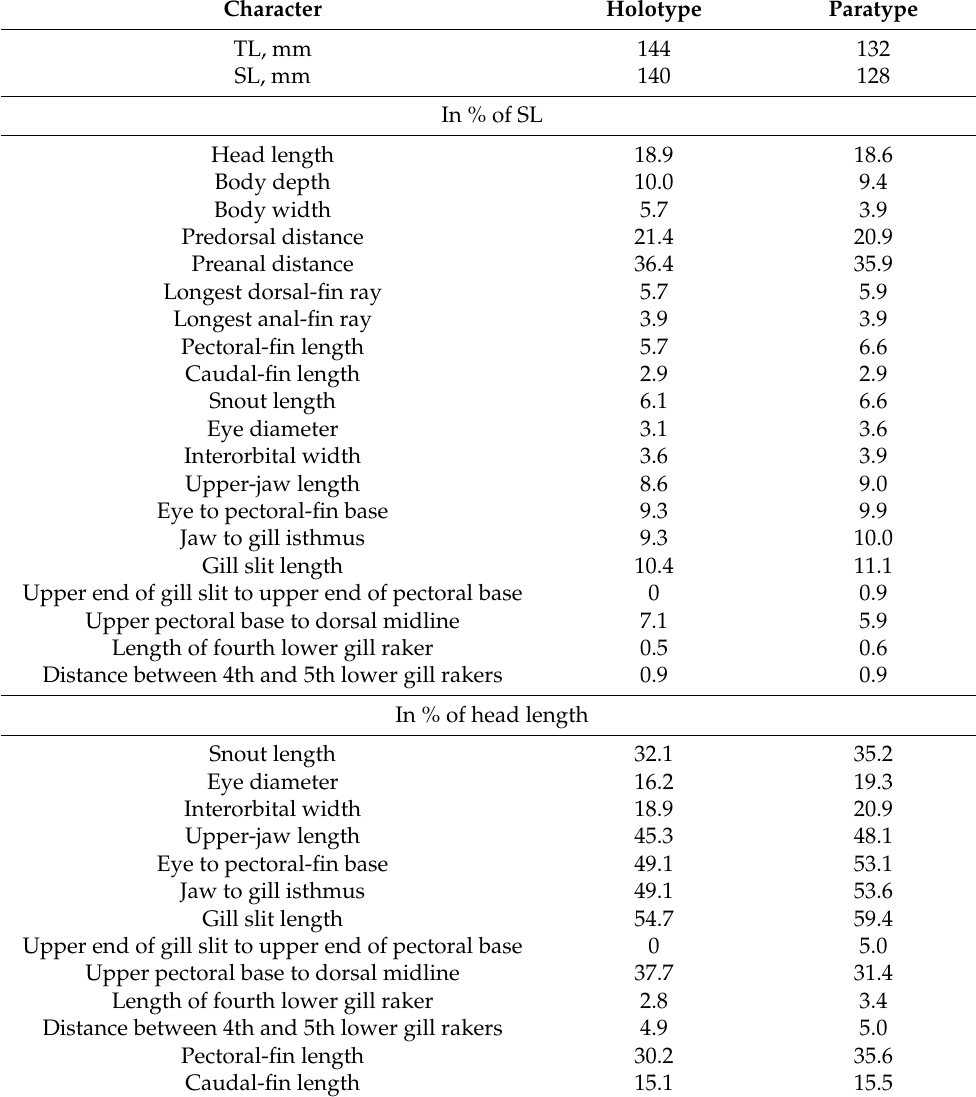
Table 2. Measurements of Lycodapus imperatorius sp.